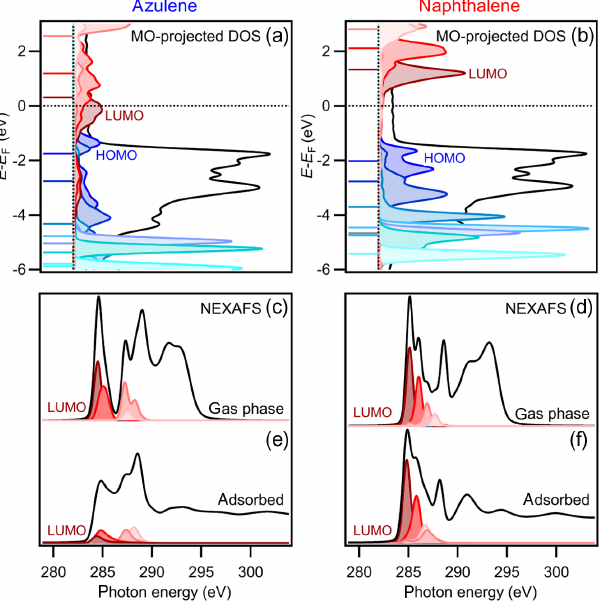
FIG. 10. MO projection analysis, left azulene, right naphthalene. Contributions of the LUMO are shown in dark red and of the HOMO in blue; higher and lower orbitals are shown in incre- mentally lighter colors. Total DOS and total spectrum are shown in black. (a,b) TDOS and MO-projected density of states of the adsorbed species with the energies of the molecular frontier orbitals. The nonvanishing TDOS around the Fermi energy is caused by the metal substrate. (c,d) MO-projected NEXAFS simulations of the free molecules. (e,f) MO-projected NEXAFS simulations of the adsorbed molecules. The simulated spectra are shifted by − 6 . 1 eV to match the experimental data in Fig. 5.